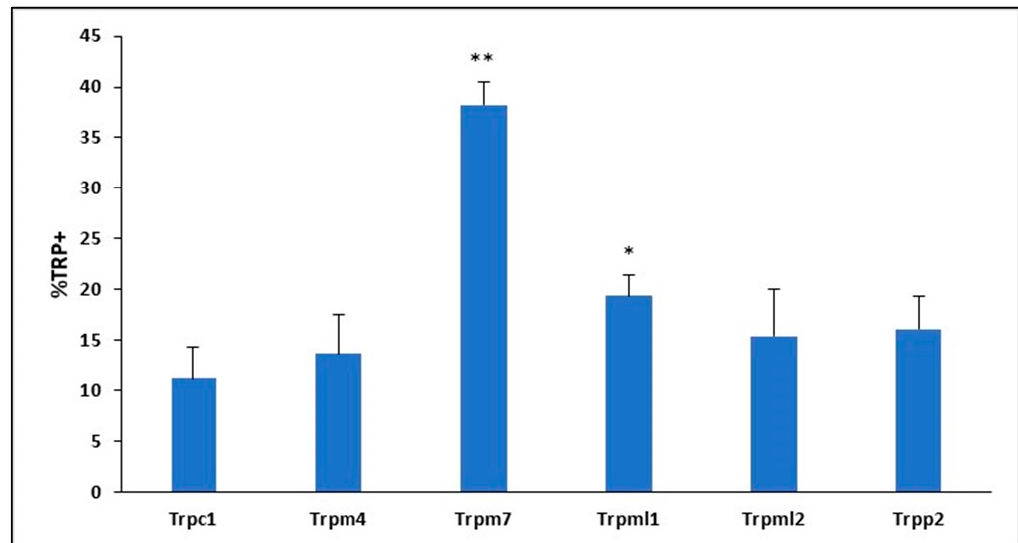
Figure 1. TRP protein channel expression in mouse BMVECs. * p < 0.05, ** p < 0.01.